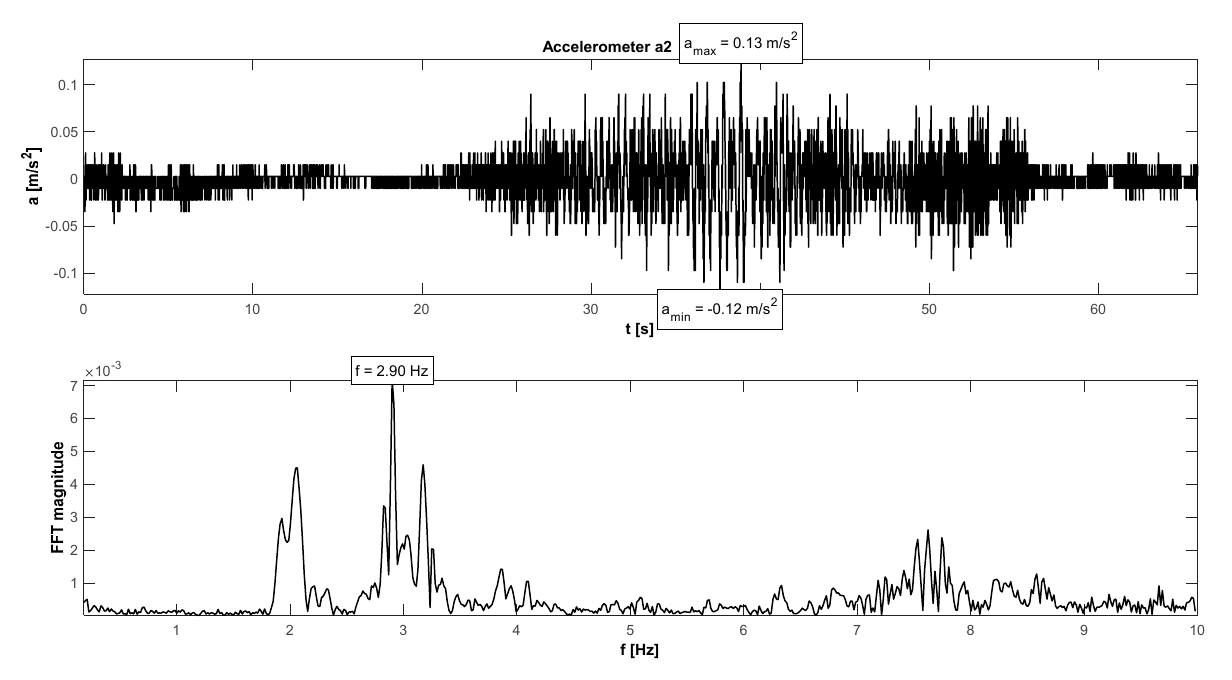
Figure 25. Signal of vertical vibrations in the time and frequency domain registered for 10 people walking.